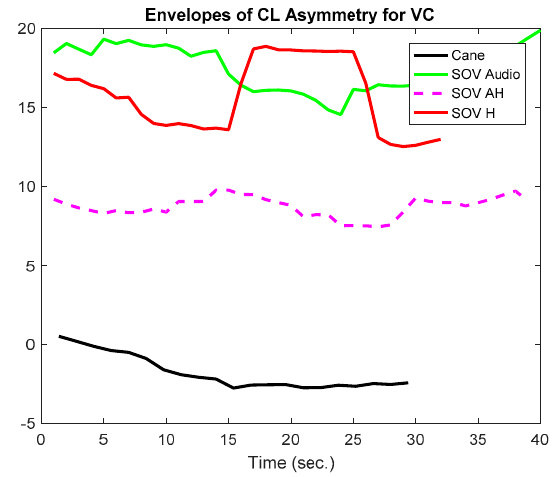
Figure 27. Visual cortex asymmetry for UserB (late-blind).